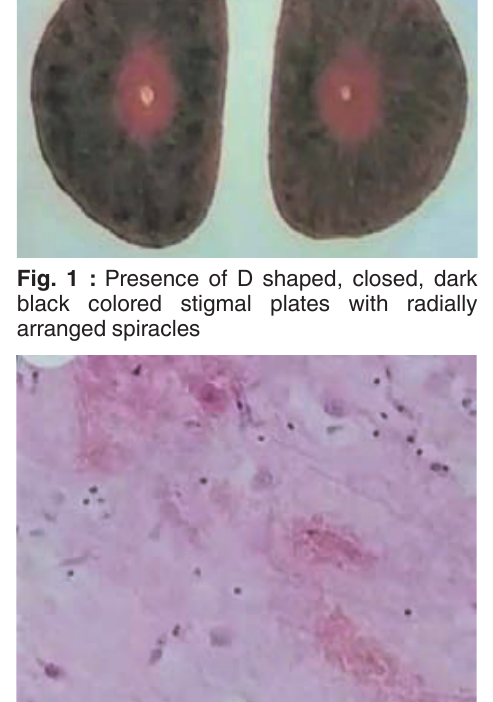
Fig. 2 : Section of cerebral cortex showing the degeneration of neuron and softening of brain